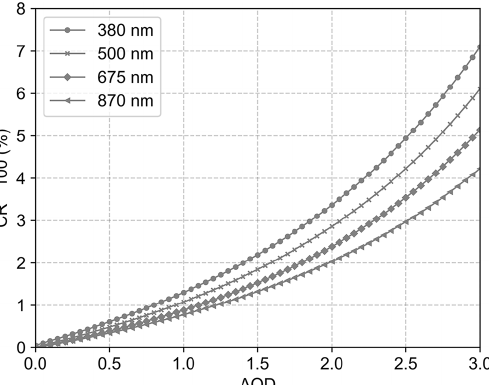
Figure 7. Simulations of CR × 100 (%) for SZA set to 30 ◦ with AOD values from 0 to 3 at 380, 500, 675, and 870nm for the 2020 annual average MERRA2 aerosols data in the Beijing area with FOV between 1.2 and 5 ◦ .